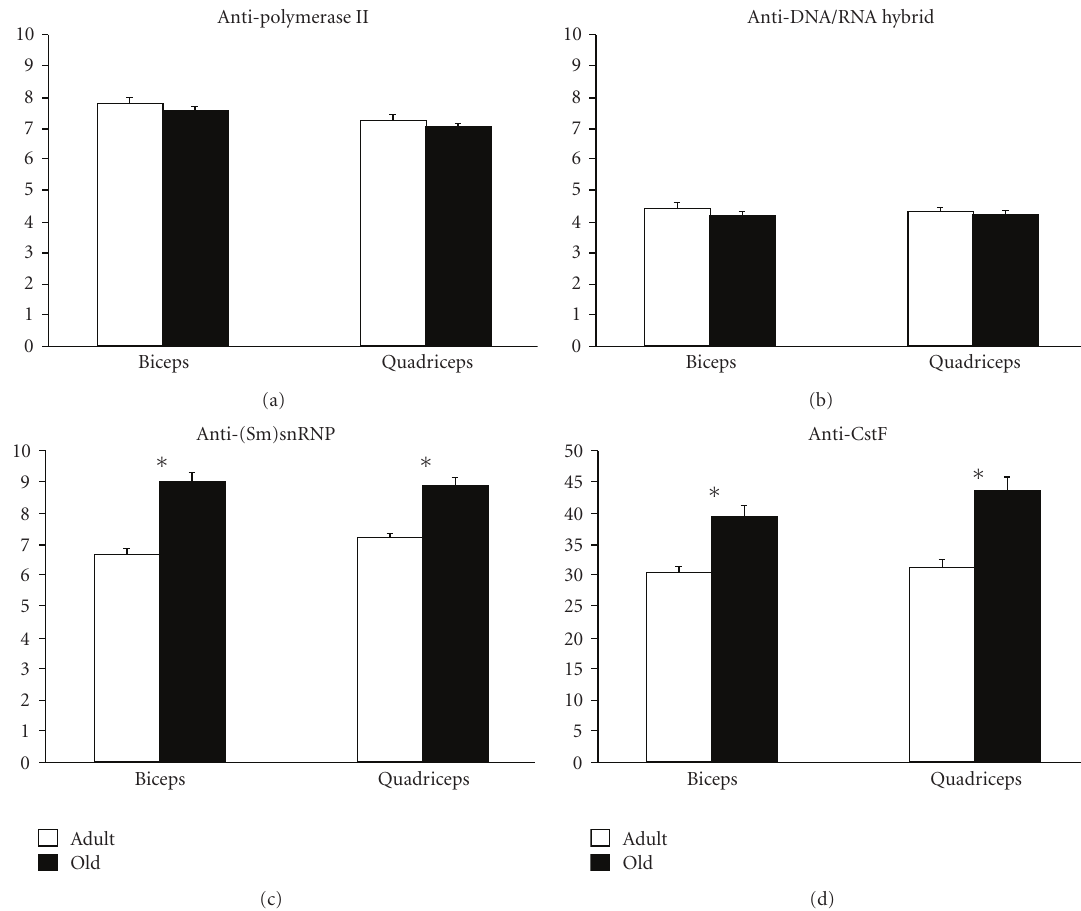
Figure 4: Quantitative immunoelectron microscopy of satellite cell nuclei of biceps and quadriceps muscles from adult and old rats; labeling density (gold grains/ μ m 2 ) of some RNA processing factors in the interchromatin space (mean ± SE). Asterisks show significantly di ff erent